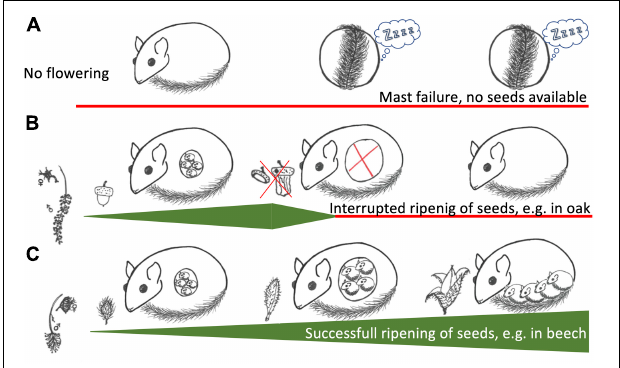
FIGURE 3 | Schematic depiction of reproductive decisions in edible dormice. (A) A situation where trees like beech or oak are not flowering, a mast failure year. In these years, reproduction will be skipped and aestivation and prolonged hibernation is observed. (B) In certain tree species, such as oak ( Quercus spec .), there is no correlation between flowering and seeding. Under these circumstances, females may be gestating if seed buds are available but resorb embryos if the food availability decreases. (C) In beech ( Fagus sylvatica ) there is a strong correlation between flowering and actual seeding. Under these conditions, females experience a steadily increasing food availability, which allows high food availability for juveniles to fatten after